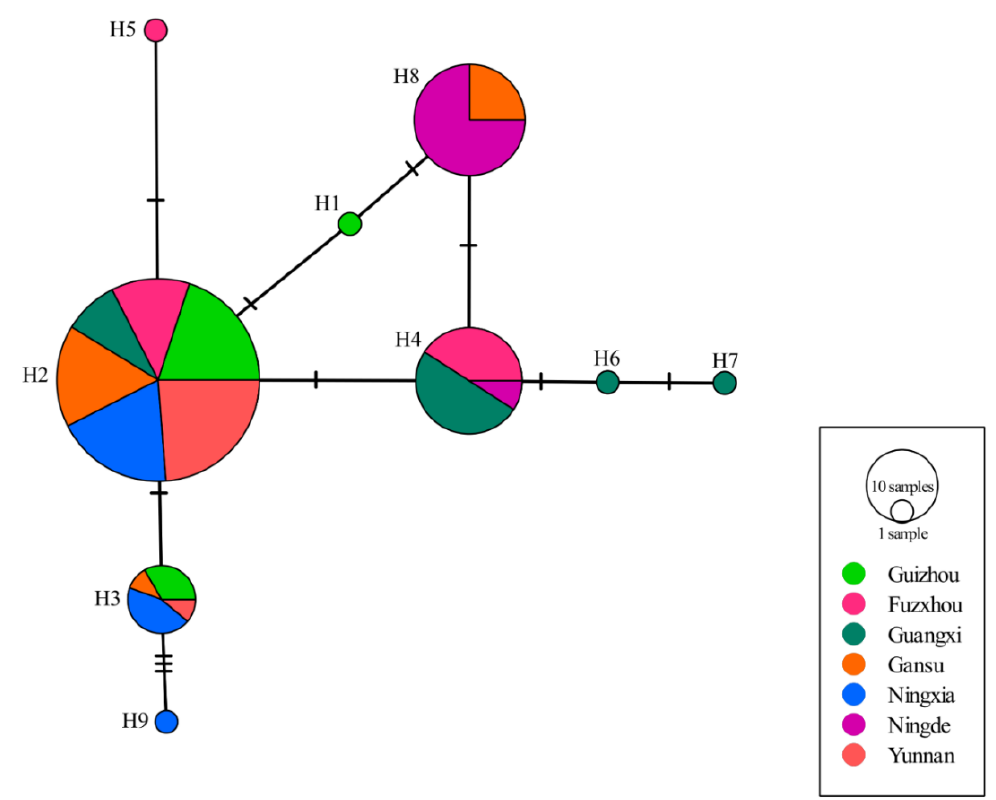
Figure 3. Haplotype network of Phytophthora infestans RAD23 gene constructed by an agglomerative approach. Nucleotide haplotypes are named by the letter H, followed by a number. Each circle represents a unique haplotype, and the size of circles indicates the frequency of isolates with that particular haplotype. Each tick mark represents a step of nucleotide substitution.